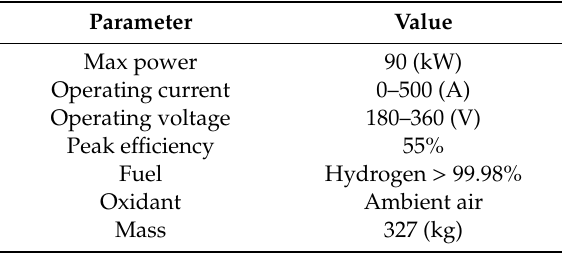
Table 5. 90 kW Hydrogenics HyPM